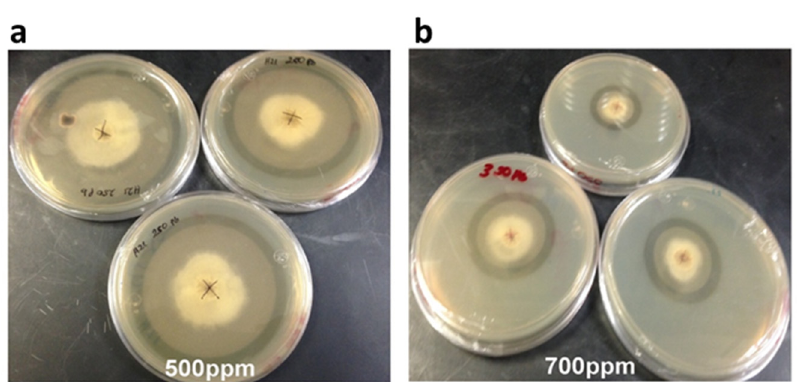
Figure 4. Growth of strain H21 in PDA with di ff erent concentrations of lead. ( a ) 500 ppm and ( b ) 700 ppm. Notice the translucent halo formed around the colony. Picture was taken after 8 days of incubation at 28 °C.